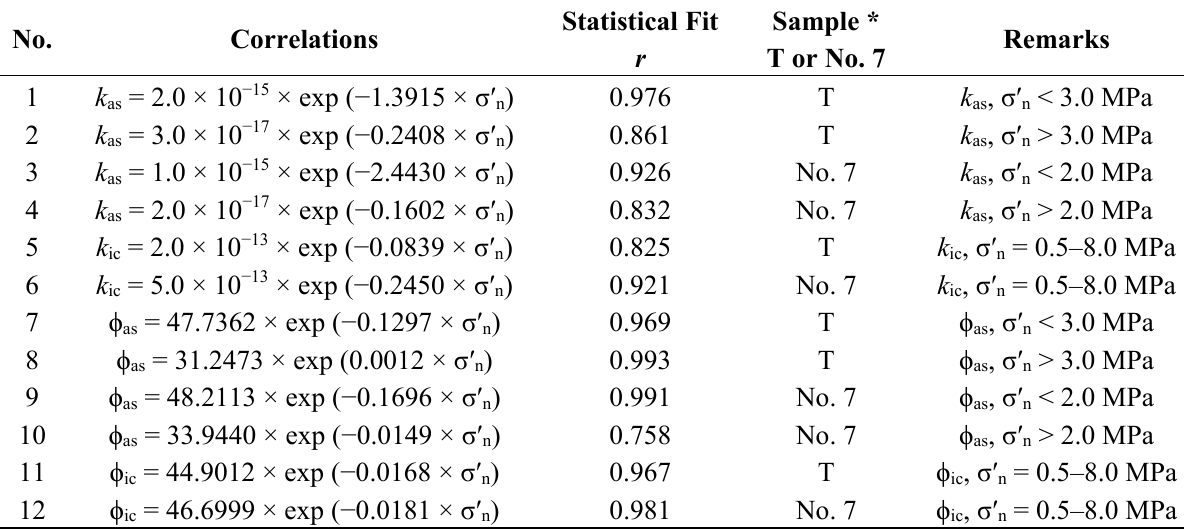
Table 2. Correlations and statistical fits obtained from various correlations in Figure 5.